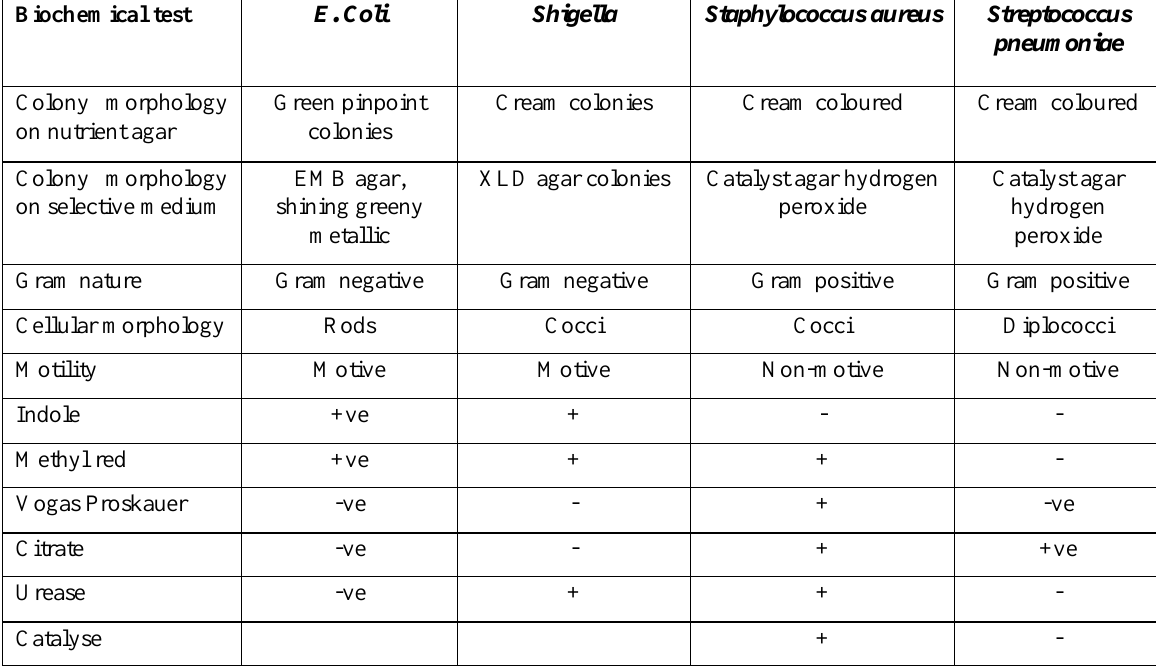
Table 3. Morphological and biochemical test for identification of the